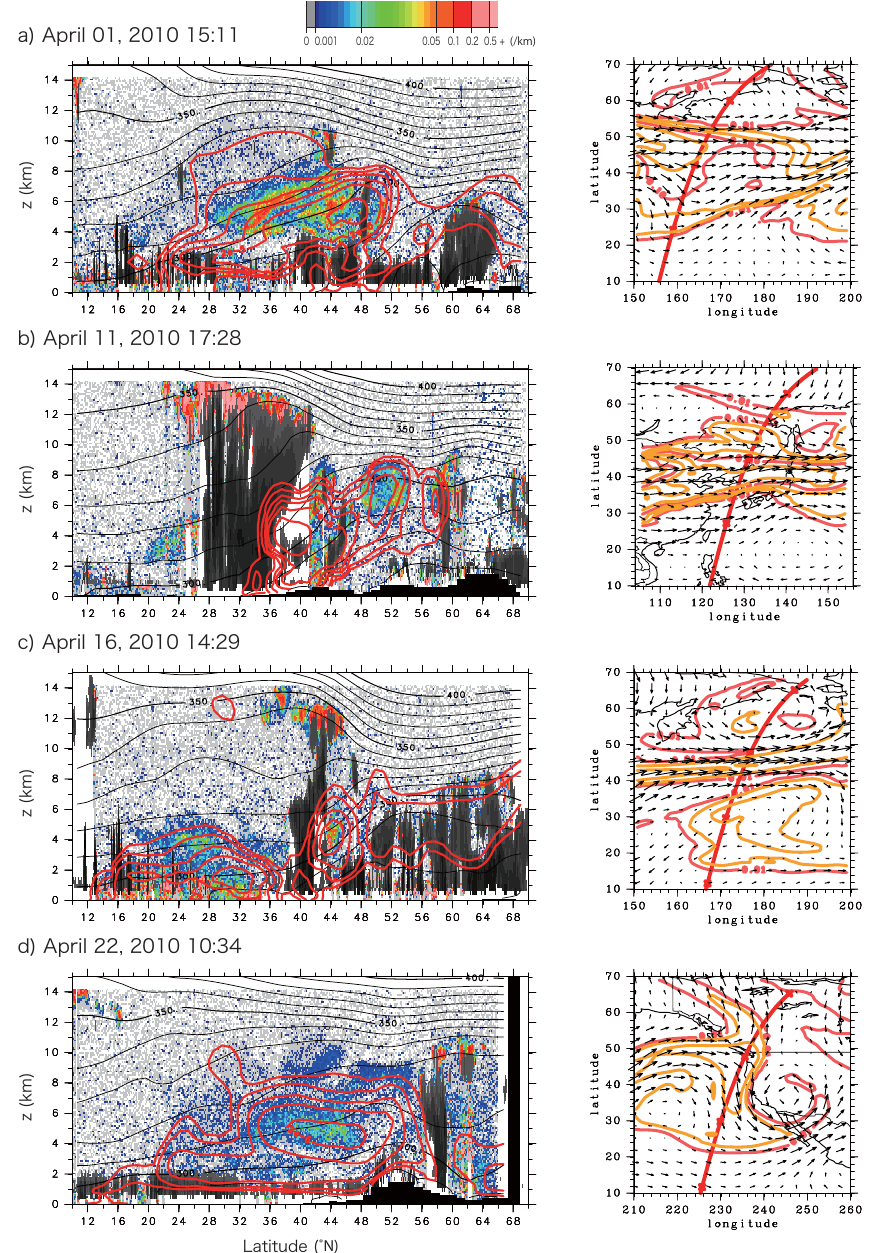
Fig. 6. The same as Fig. 2 but for downwind regions on (a) 1 April for the central/north Pacific Ocean, (b) 11 April for East Asia, (c) 16 April for the central/north Pacific, and (d) 22 April for the west coast of North